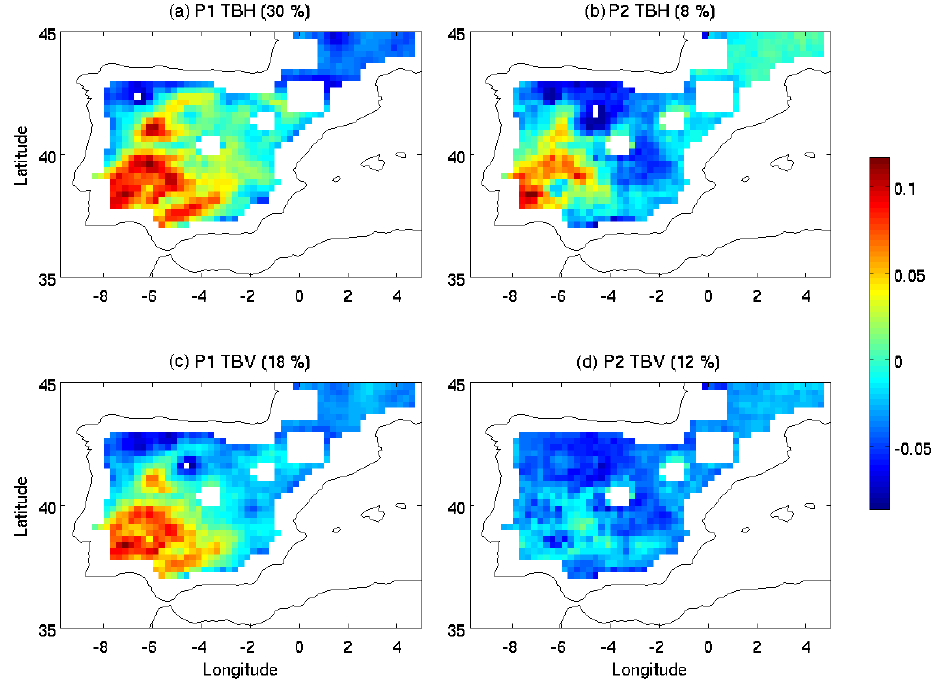
Figure 4. As Fig. 3 but for